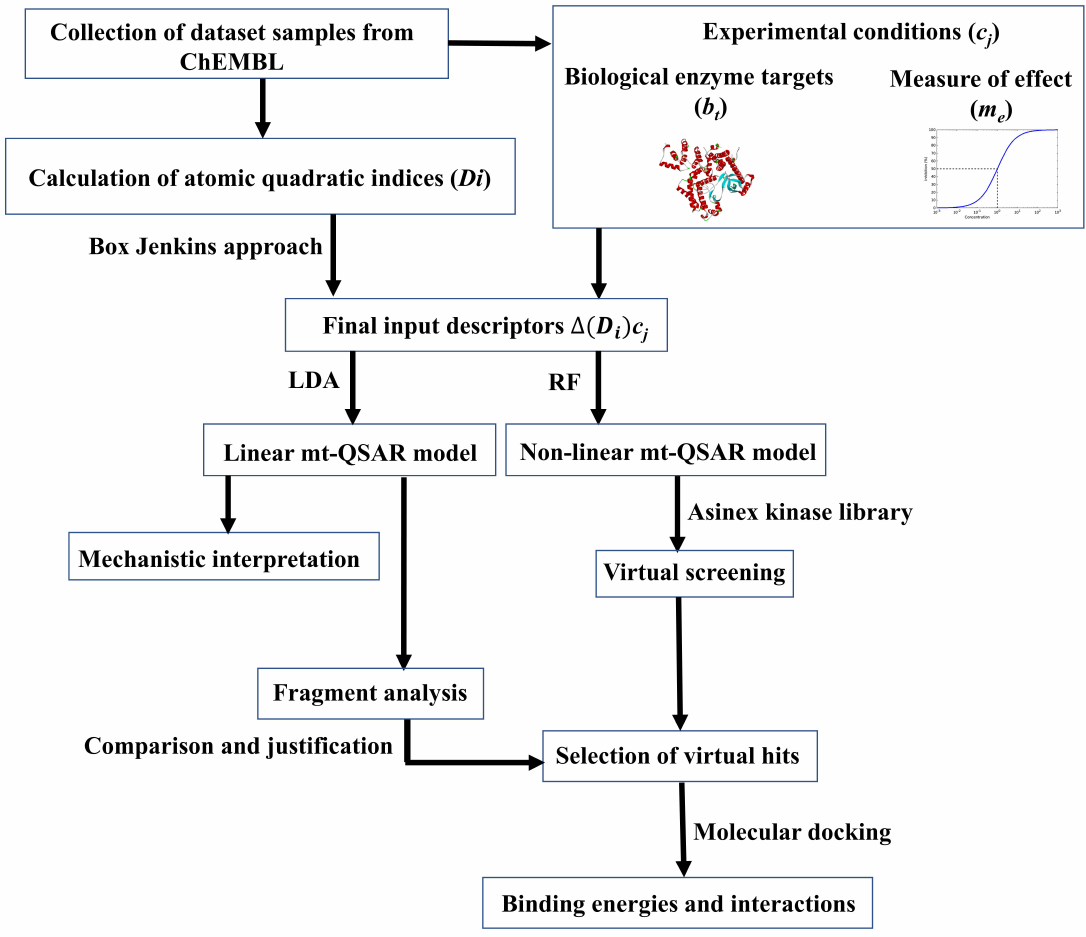
Figure 1. Flowchart showing the investigation performed in the current